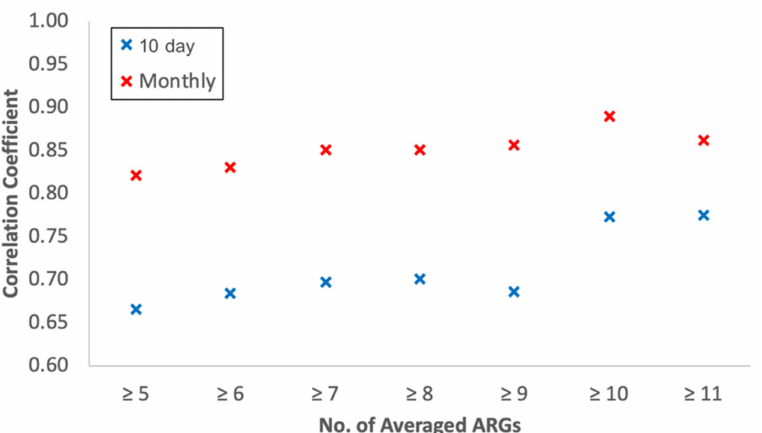
Figure 13. Variability of correlation coefficients based on number of ARGs within IMERG FR’s